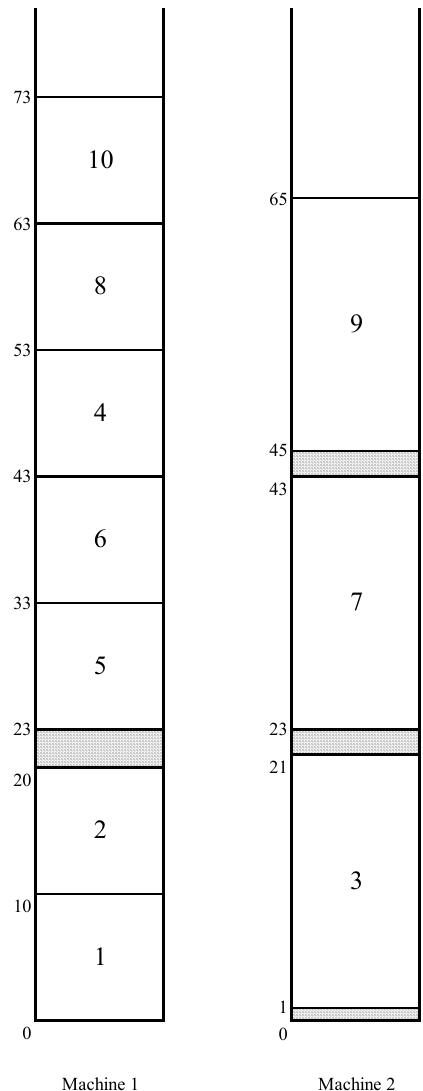
Figure 2. The C-schedule σ 4